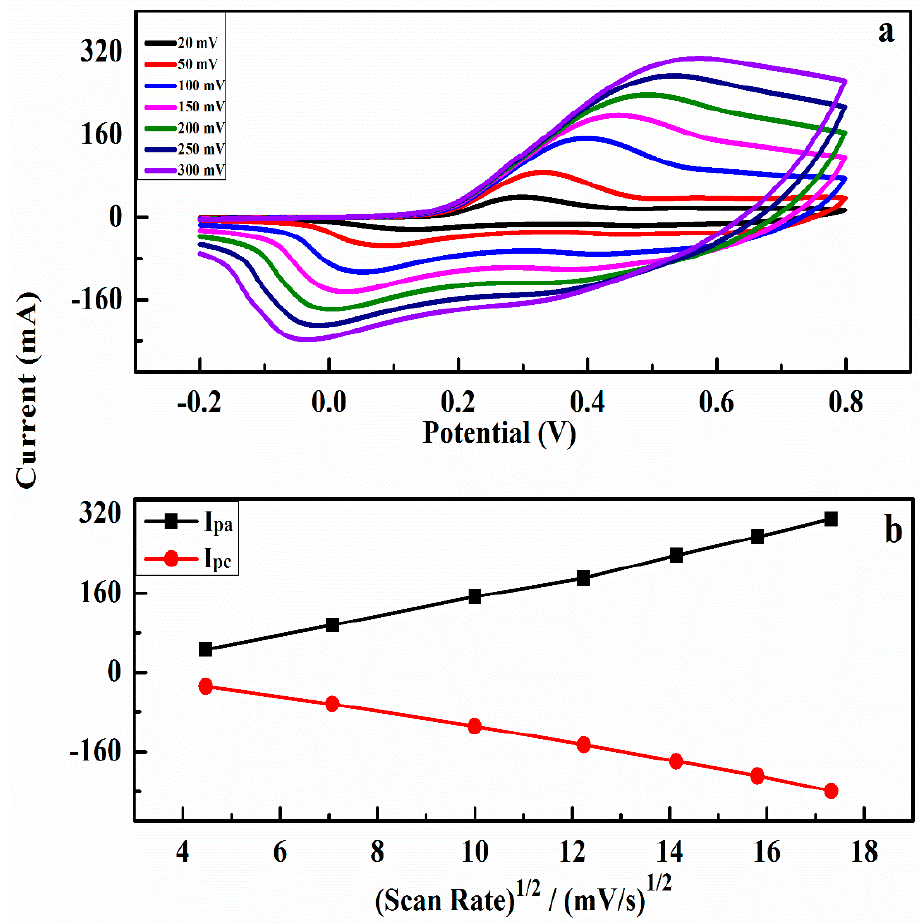
Figure 5. ( a ) CV curves of P-5PA film at various scan rates in 1 M H 2 SO 4 solution; ( b ) relation of cathodic and anodic peaks of P-5PA against the square route of the scan rate .